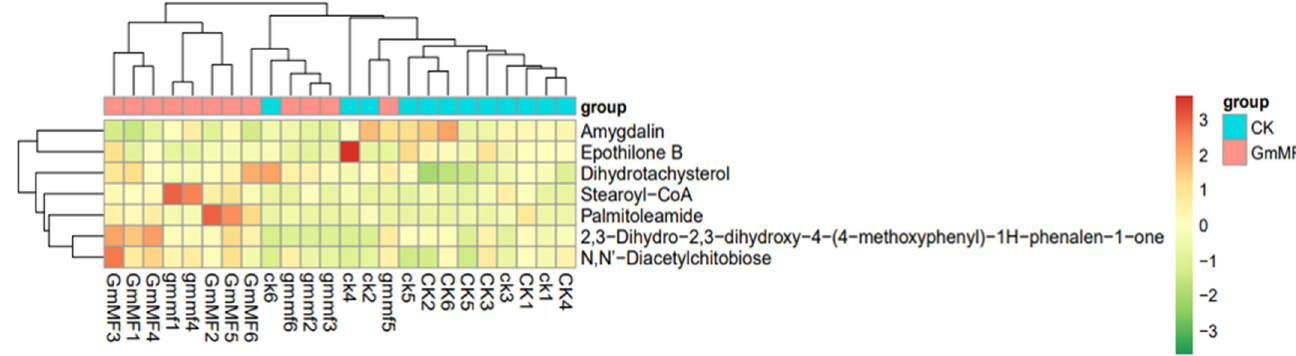
Figure 6. The heat map of differential metabolites accumulated in maize plant roots under un-inoculated and Gm + MF inoculated treatments at 0 and 75 mM NaCl conditions. CK, un-inoculated treatment, GmMF, Gm + MF inoculated treatment. Lower case letters (ck and gmmf) stand for 0 mM NaCl treatment, uppercase letters (CK and GmMF) stand for 75 mM NaCl treatment. n = 6.